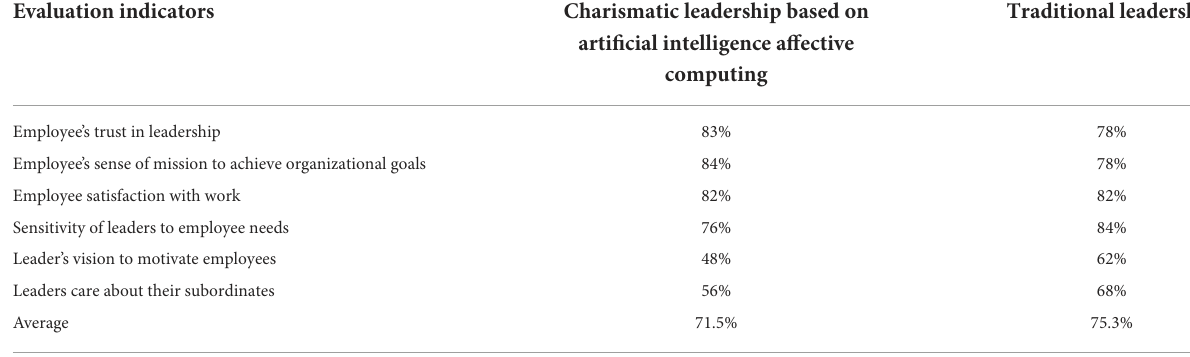
TABLE 2 Predictive analysis indicators of psychological states that affect leaders’ attitudes toward employees’